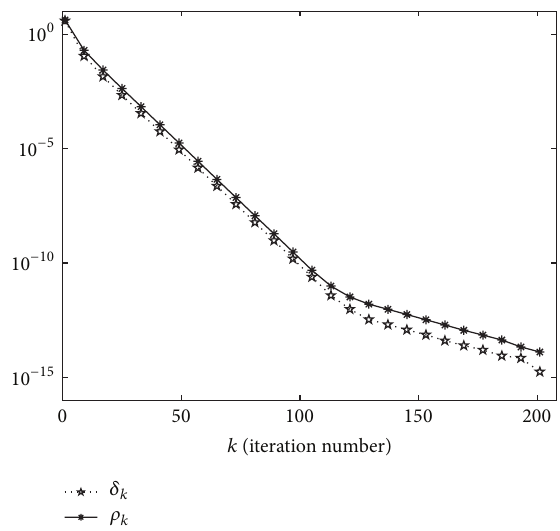
Figure 1: ‖𝑌 𝑘+1 − 𝑌 𝑘 ‖ 𝐹 and ‖𝑍 𝑘+1 − 𝑍 𝑘 ‖ 𝐹 for Example